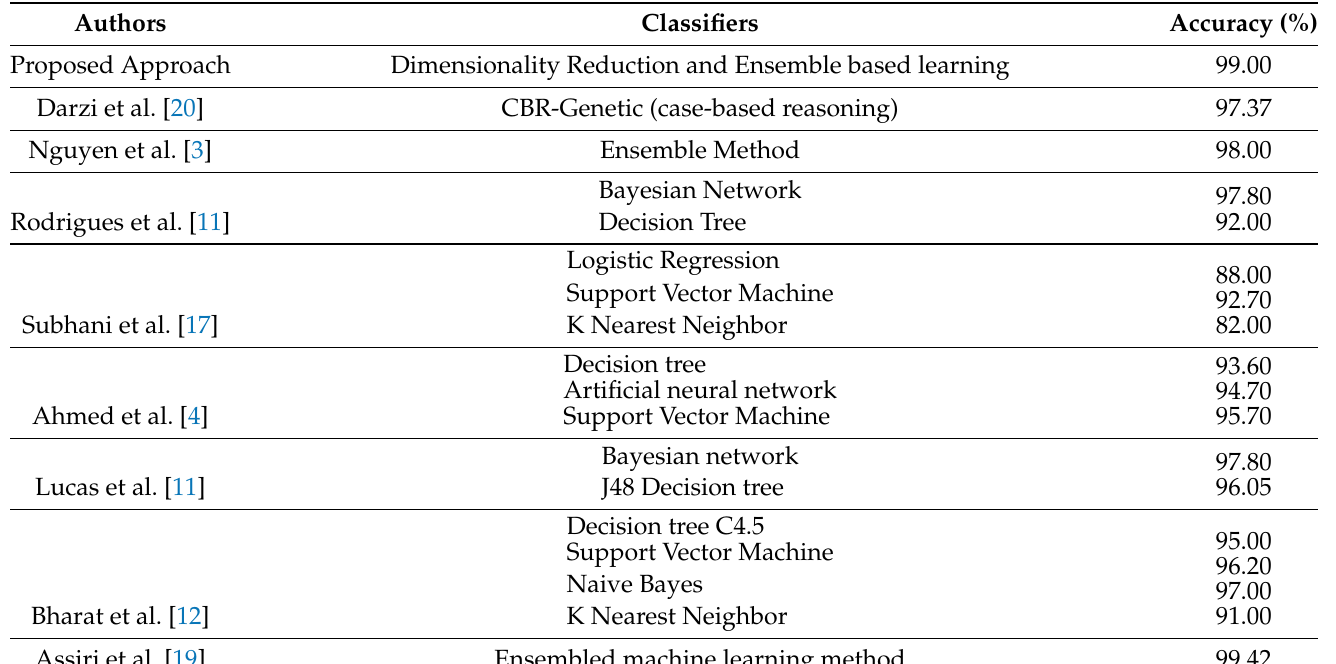
Table 6. Comparison with the existing work for breast cancer